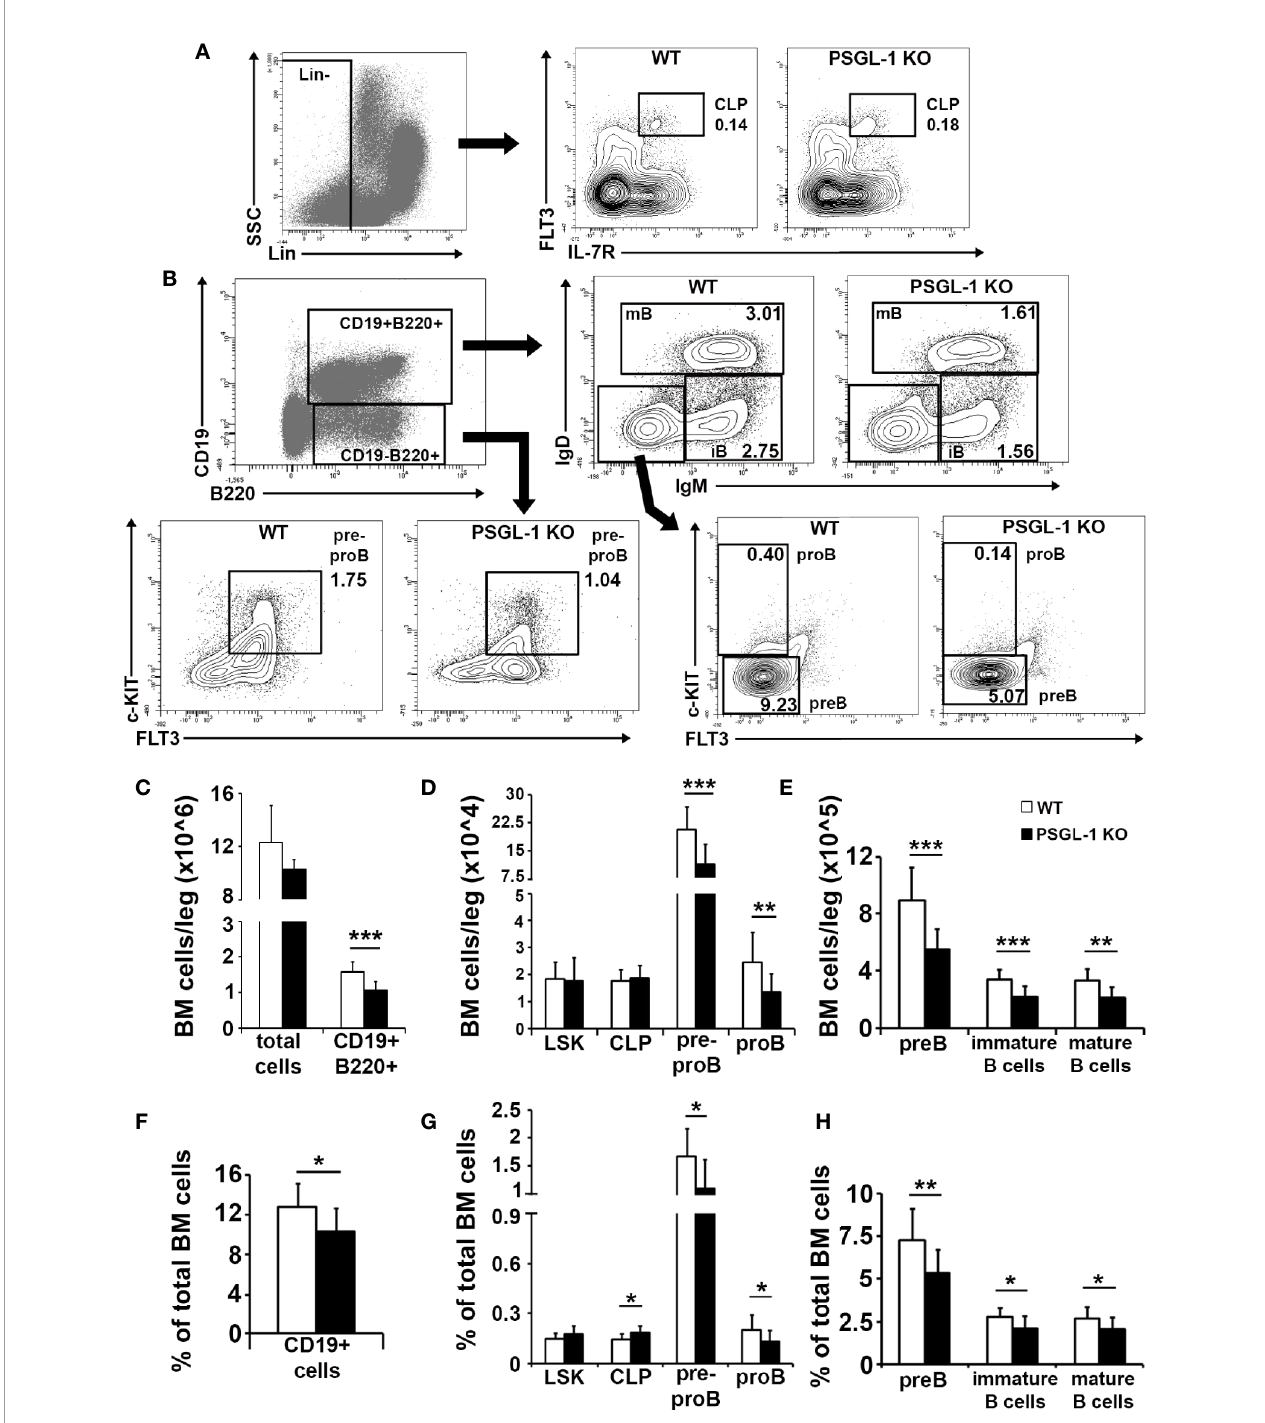
FIGURE 2 | B cell generation is impaired in the bone marrow of PSGL-1 − / − mice. (A) Gating strategy for bone marrow lineage negative (Lin − ) gating (left panel) and representative dot/density plots of common lymphoid progenitors (CLP) of WT and PSGL-1 − / − mice (middle and right panels). (B) Gating strategy and representative dot/density plots showing bone marrow pre-pro B, pro-B, pre-B, immature (iB), and mature (mB) B cells of WT and PSGL-1 − / − mice. (C – E) Total number of cells of the following populations in the bone marrow of WT and PSGL-1 − / − mice: CD19 + B220 + B cell lineage-committed cells (C) ; Lin − Sca-1 + c-KIT + (LSK), CLP, pre-pro B and pro-B (D) ; pre-B, immature B cells and mature B cells (E) . (F – H) Relative frequencies of the following populations in the bone marrow of WT and PSGL-1 − / − mice: CD19 + B220 + B cell lineage-committed cells (F) ; LSK, CLP, pre-pro B and pro-B (G) ; pre-B, immature B cells, and mature B cells (H) . Bars represent the mean+standard deviation. *p < 0.05, **p < 0.01, ***p < 0.001 analyzed by Student ’ s t test. In all cases, n = 12 mice per